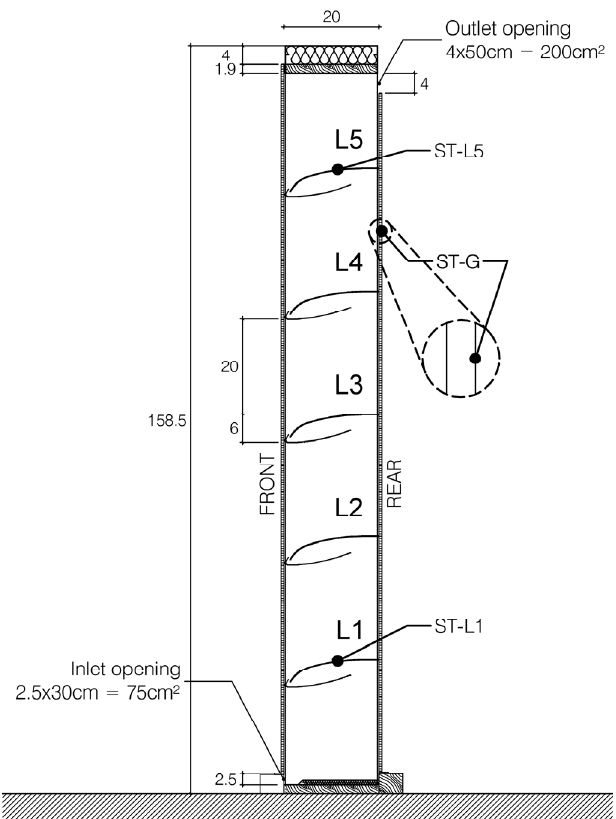
Figure 1. Dimensions of the model and location of the sensors (units in cm).